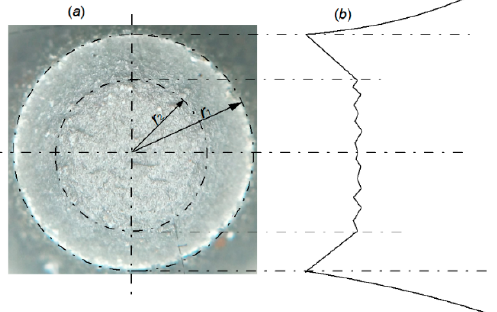
Figure 13. View of break surface of the tensile specimen ( a ) and a scheme of the break plane pro- file ( b ).